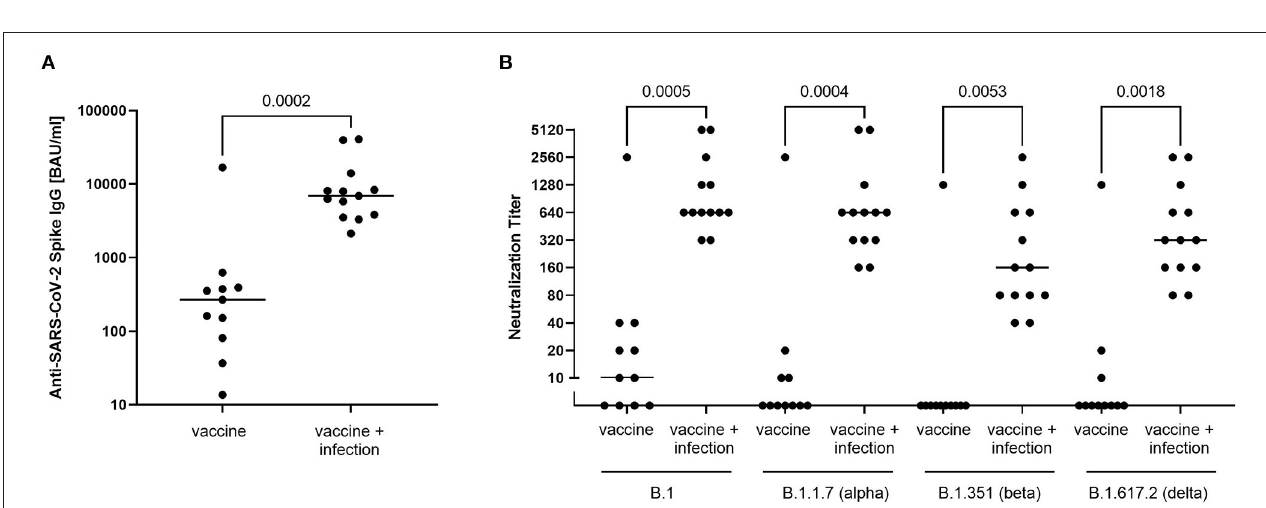
FIGURE 2 | Humoral immune response against SARS-CoV-2. (A) anti-SARS-CoV-2 spike IgG titres were measured as binding antibody units/ml (BAU/ml) using Euroimmun anti-SARS-CoV-2-QuantiVac-ELISA. For comparison of the two groups, a Mann-Whitney test was performed with the p-value depicted in the figure. (B) To determine the anti-SARS-CoV-2 neutralisation capacity against SARS-CoV-2 B.1, SARS-CoV-2 B.1.1.7 (alpha variant), SARS-CoV-2 B.1.351 (beta variant) and SARS-CoV-2 B.1.617.2 (delta variant), a serial dilution endpoint neutralisation test was performed for the two groups. The reciprocal of the NT titre is depicted, bars represent the respective median. For comparison of the groups, a one-way ANOVA (Kruskal-Wallis test) with Dunn’s correction for multiple comparisons was performed. The p-values are depicted in the figure.